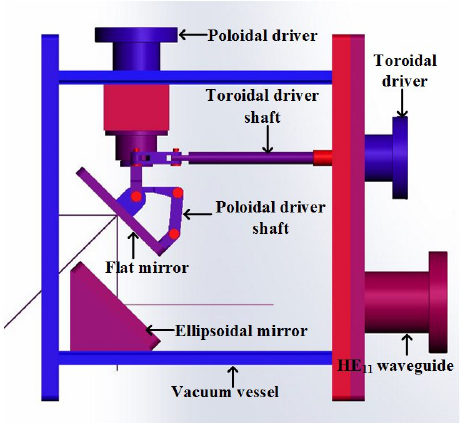
Fig. 2 . Structure of the designed 105GHz launcher.